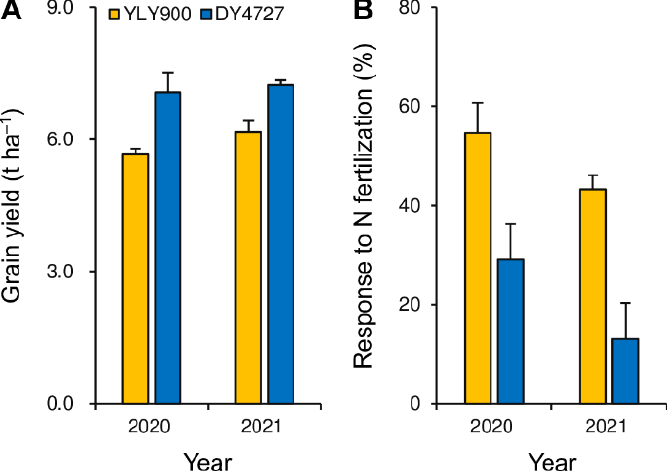
Figure 2. Grain yield ( A ) under the zero-N fertilization condition and its response to N fertilization (180 kg N ha − 1 ) relativized to zero-N fertilization ( B ) in two hybrid rice varieties, Deyou